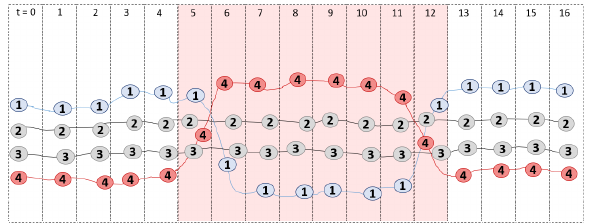
Figure 1. A synthetic example containing the trajectories of four group members (numbered dots). Objects 1 (blue) and 4 (red) change their positions within the group for a certain period of time before they return to their original